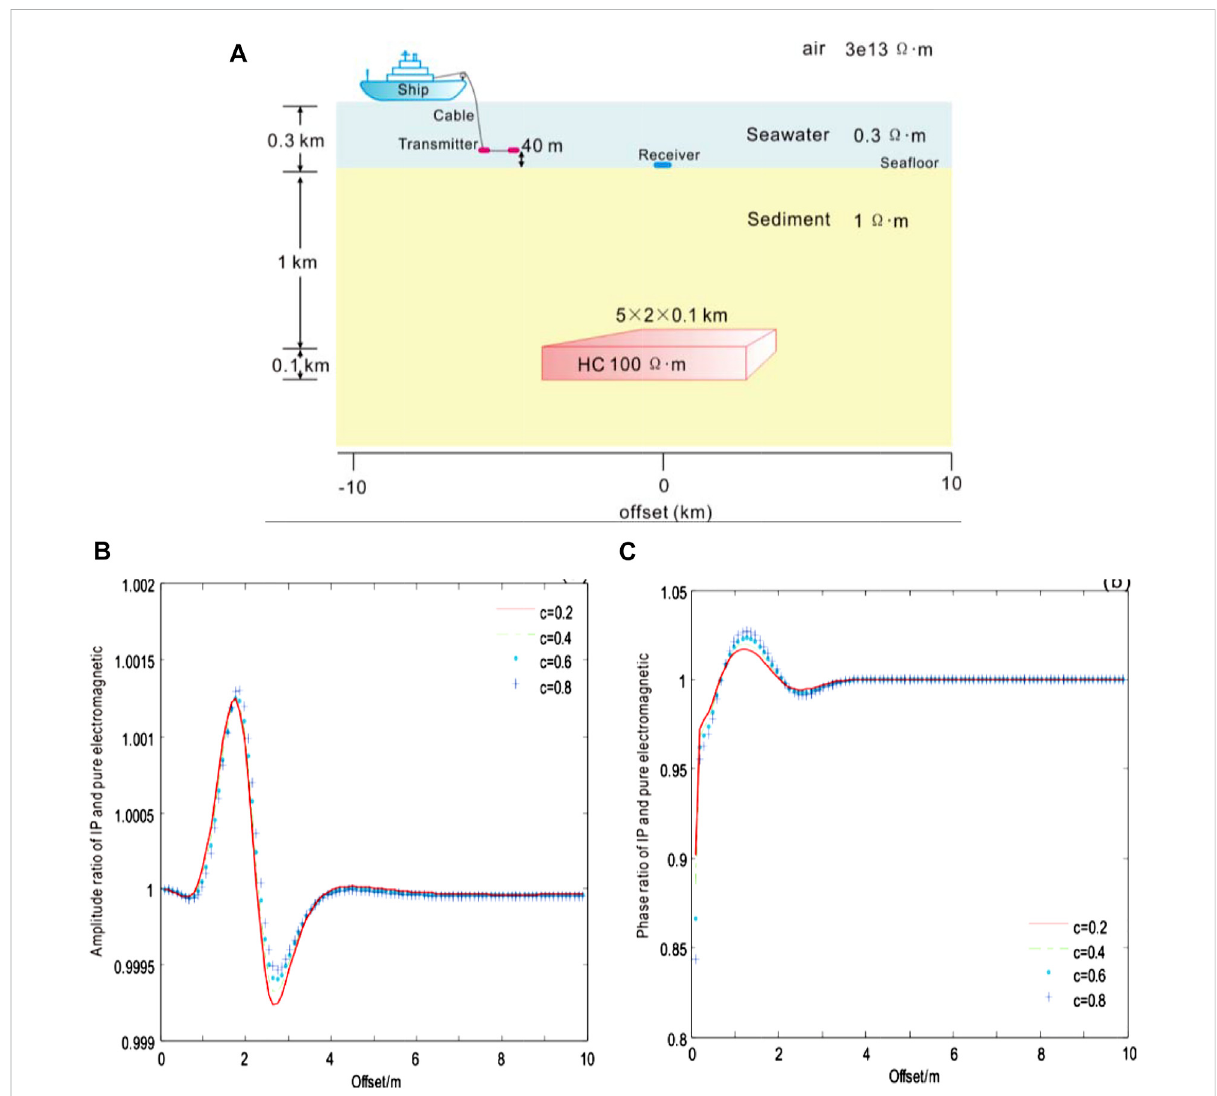
FIGURE 7 Amplitude and phase ratio of CSEM with the IP and pure electromagnetic fi eld to the Cole – Cole model of various frequency correlation coef fi cientsc=0.2(red),0.4(green),0.6(blue),and0.8(lightblue),respectively. (A) Geoelectricmodelofsubmarinehydrocarbonswithion-induced polarization in the 3D marine CSEM, (B) the ratio of amplitude, and (C) the ratio of